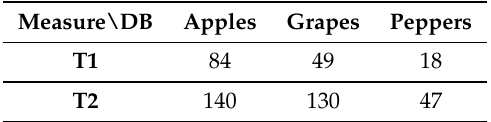
Table 2. T1 and T2 values determined for each database.